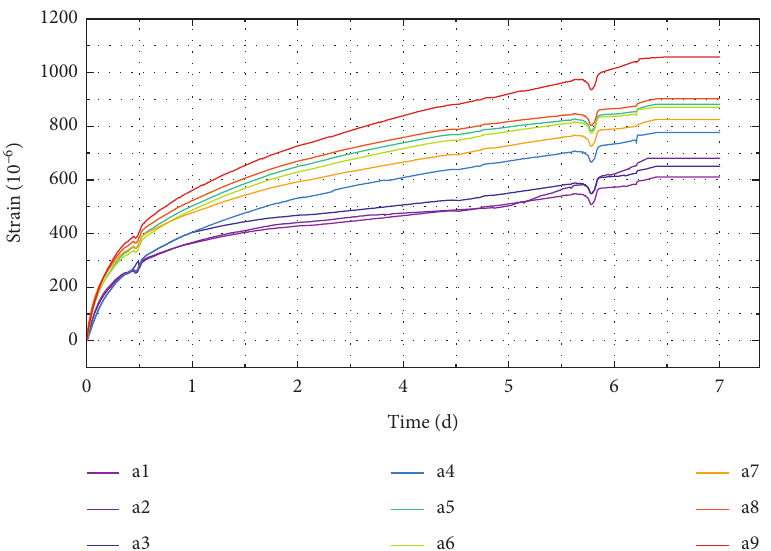
Figure 7: − 1816m core sample anelastic recovery strain